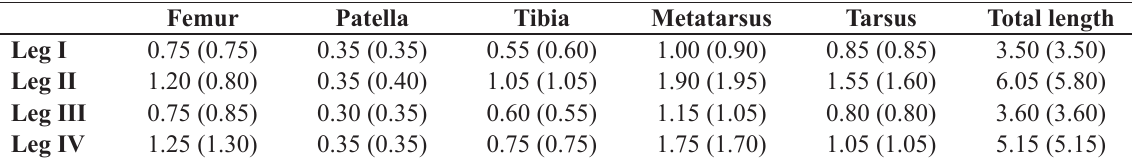
Table 2. Length of appendage-segments in millimeters (trochanters not presented) in N. bidentatum bidentatum Roewer, 1914 from Bärental, Austria: ♂ (♀) (from Gruber & Martens Femur Patella Tibia Metatarsus